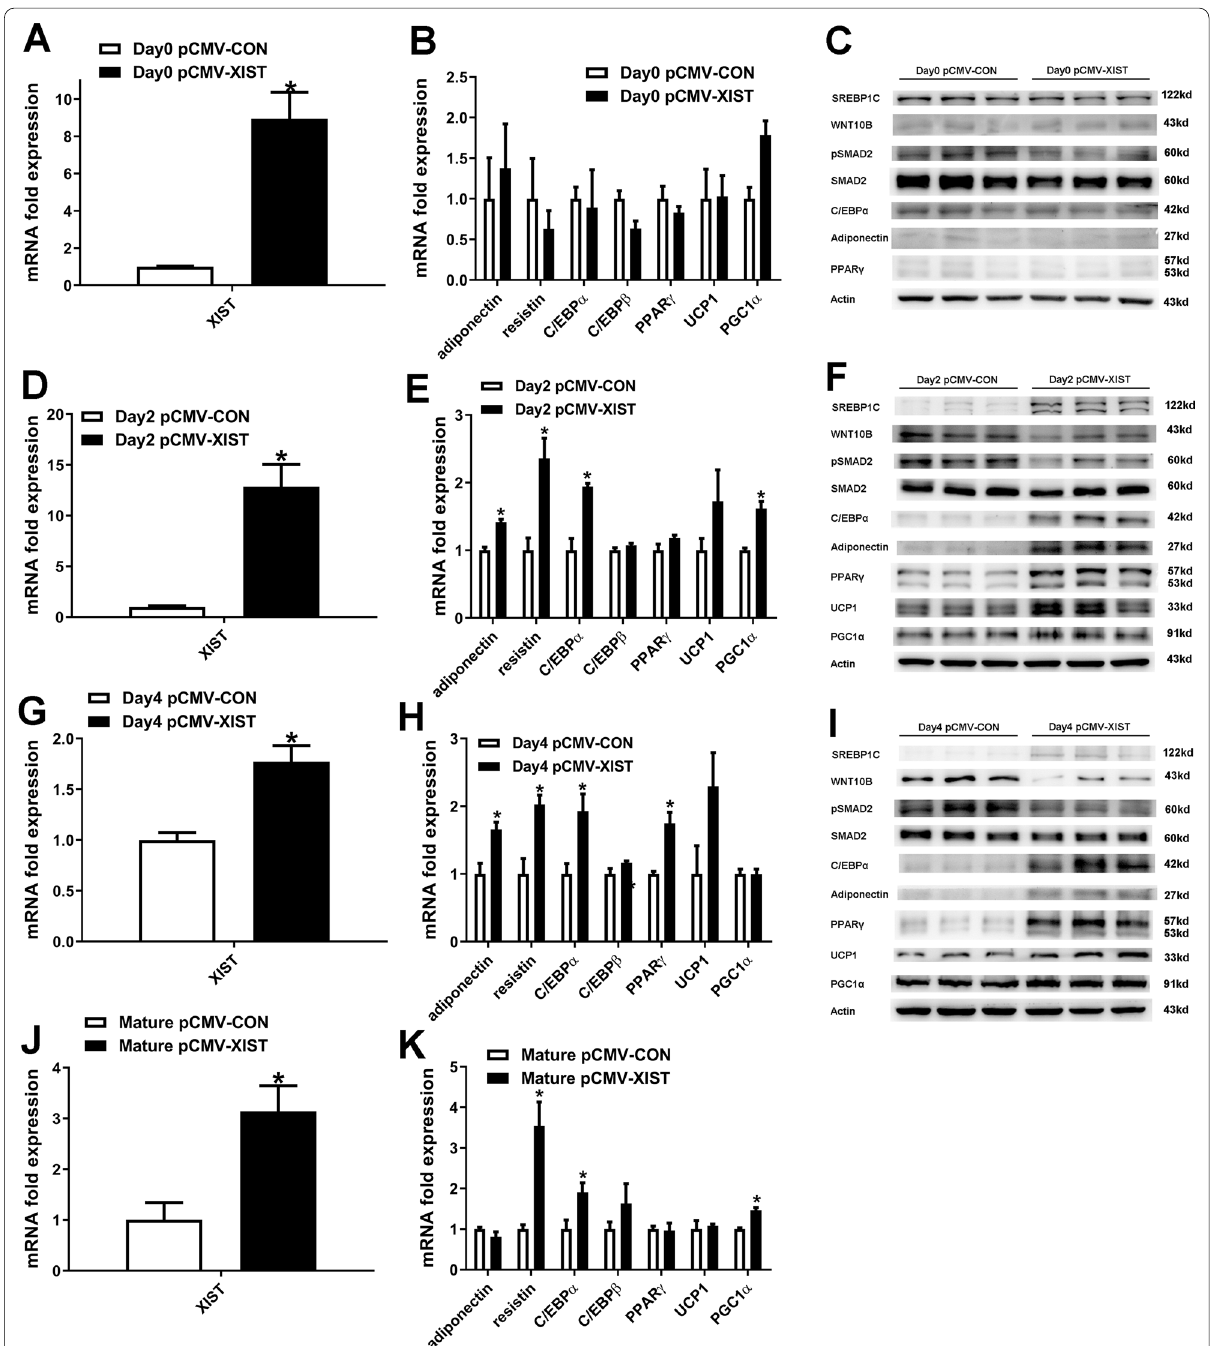
Fig. 2 Overexpression of XIST promotes brown preadipocyte differentiation. A – B , D – E , G – H , qRT-PCR analysis of XIST and indicated genes during the differentiation of brown preadipocytes transfected with control or XIST overexpression plasmid. C , F , I Western blot analysis of the expression of indicated proteins during the differentiation of brown preadipocytes transfected with control or XIST overexpression plasmid. J – K qPCR analysis of XIST and indicated genes in differentiated brown preadipocytes transfected with control or XIST overexpression plasmid. *, p < 0.05. Data are represented as mean ±